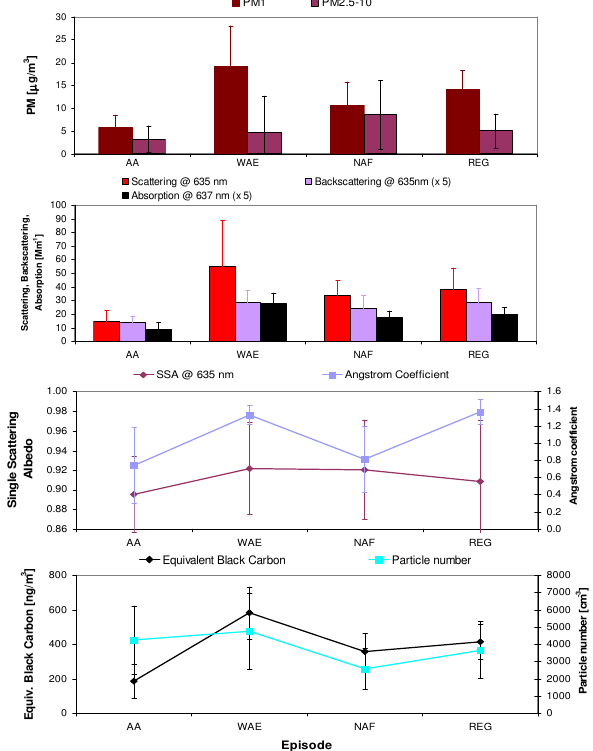
Fig. 9. Aerosol components and parameters as a function of air mass origin: AA=Atlantic Advection; WAE=Winter Anticyclonic Episode; NAF: Saharan dust outbreaks; REG=Regional stagnation